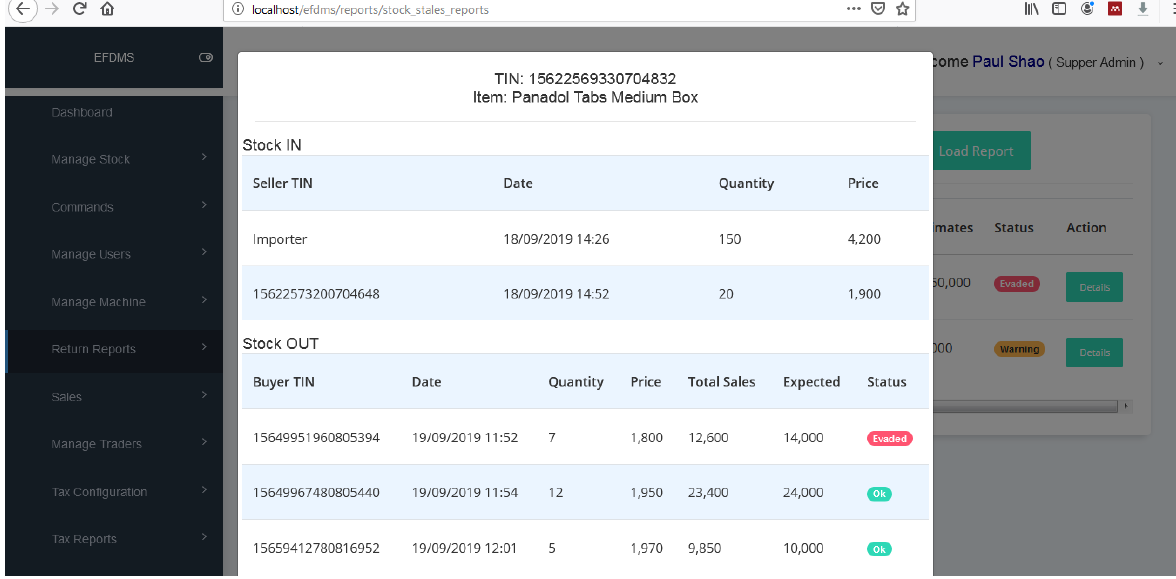
Figure 13. Traders stock account in